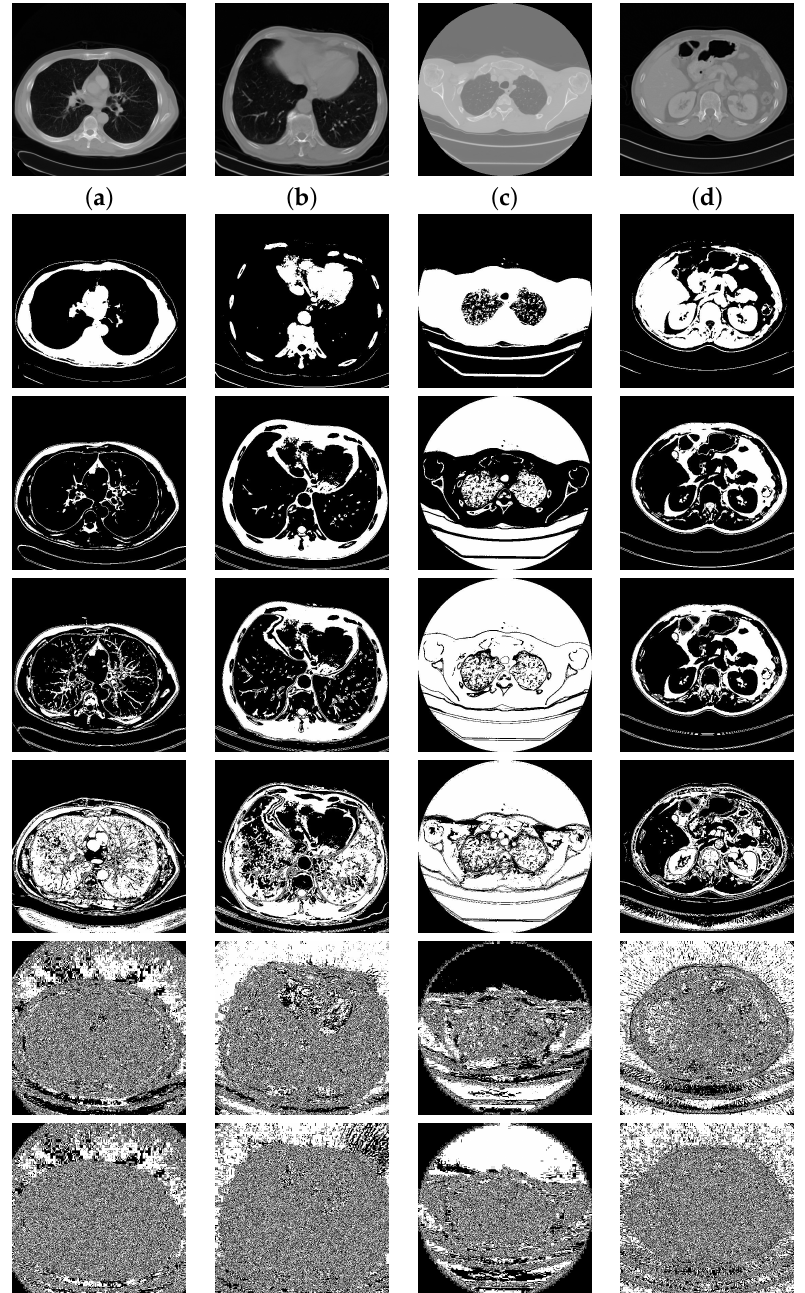
Figure 7. Bit planes extracted from the medical images (Row 1: original images; ( a ) medical image-1; ( b ) medical image-2; ( c ) medical image-3; ( d ) medical image-4. Row 2: plane 7; row 3: plane 6; row 4: plane 5; row 5: plane 4; row 6: plane 1; Row 7: Plane